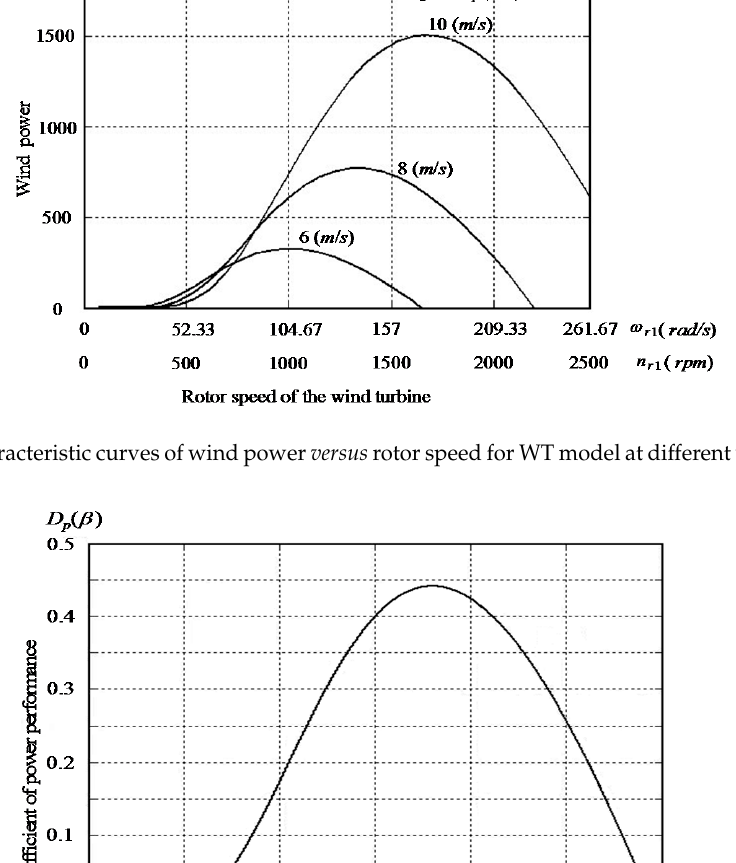
Figure 2. Characteristic curve of coefficient ( β )